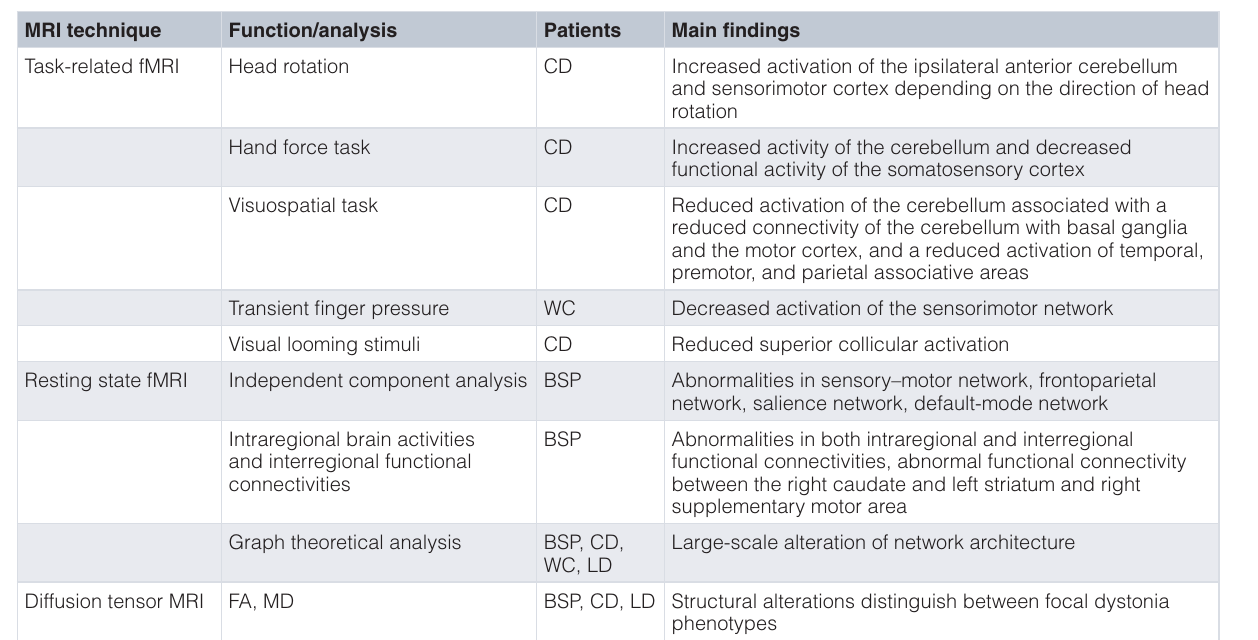
Table 2. Recent neuroimaging abnormalities in focal